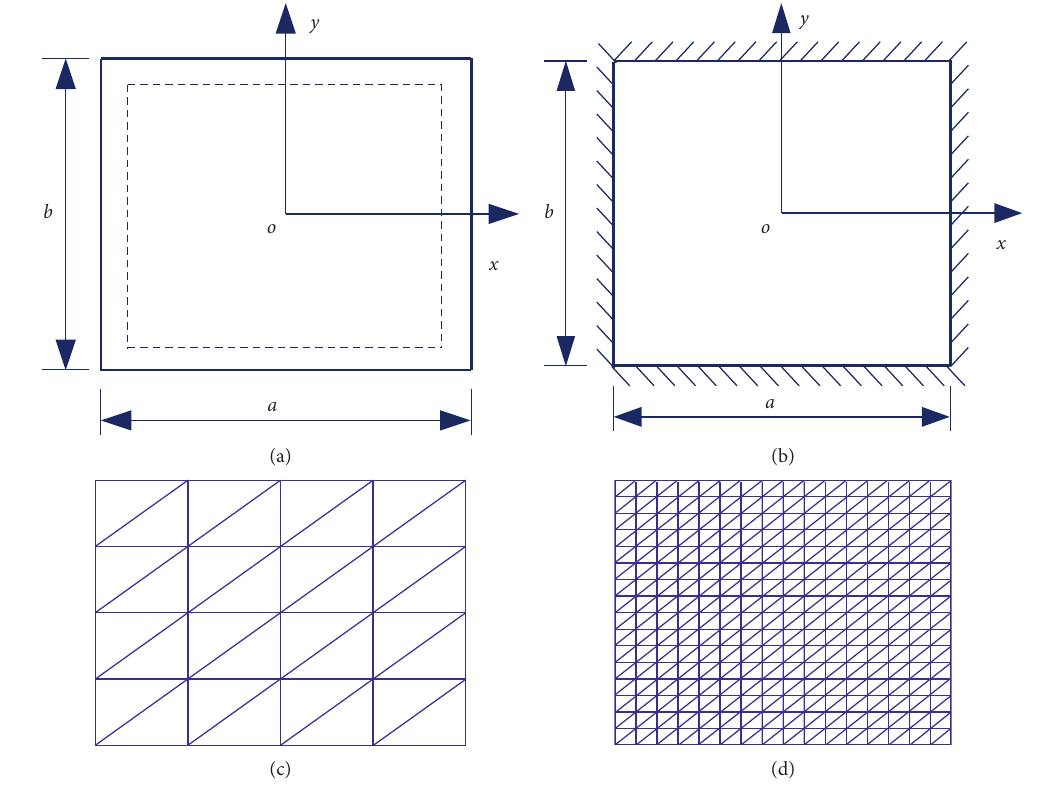
Figure 10: (a) Supported plate, (b) clamped plate, and (c, d) triangular meshes. Table 2: A nondimensional frequency parameter λ of an SSSS plate ( a / b ) �